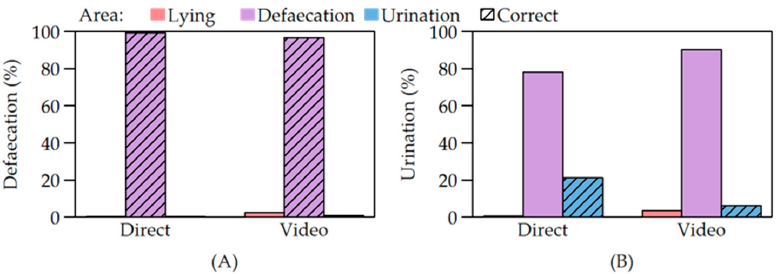
Figure 3. ( A ) Percentages of defaecations; ( B ) percentages of urinations in the lying area, defaecation area and urination area of the pig toilet depending on the observation method (direct observation or video analysis).